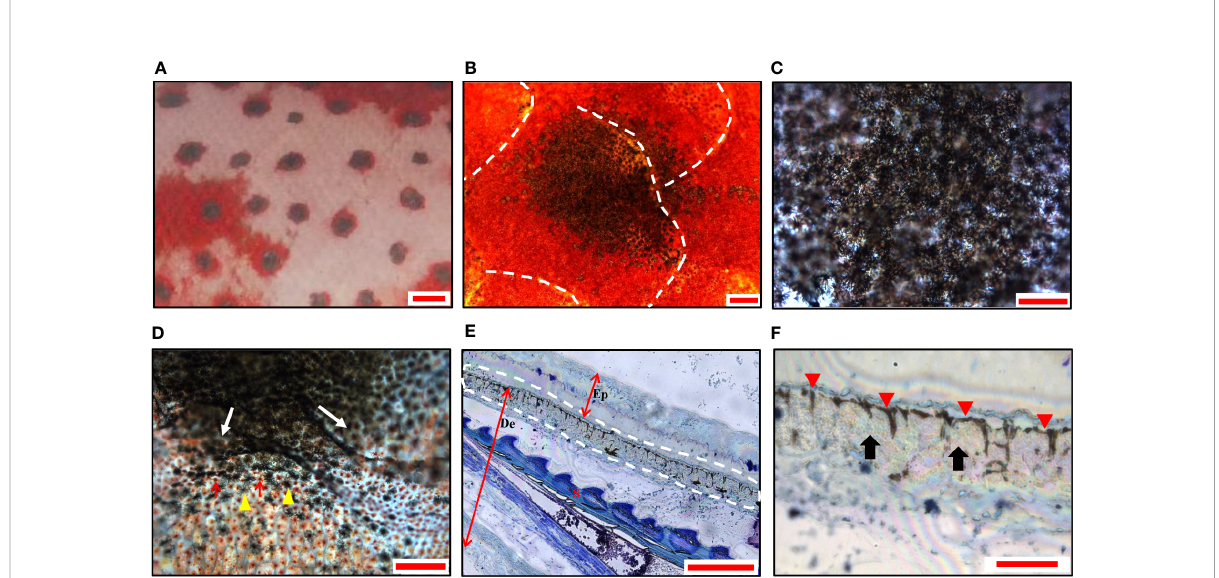
FIGURE 3 Morphology and chromatophores distribution of black spots in leopard coral trout. (A) A magni fi ed image of the skin shows black spots with irregular shaped. (B) A panoramic image shows black spots distributed over multiple scales under a light microscope. (C) The center of the spot is black. (D) The edges of the black spots (white arrows). Melanophores (yellow arrowheads); Erythrophores (red arrows). (E) A representative image of semi-thin sections (toluidine blue staining), shows continuously dispersed melanophores in the dermis. The white dashed line indicates the chromatophores. Ep, epidermis; De, dermis; S, scale. (F) The magni fi cation of the partial image in (E) shows dispersed melanophores (red arrowheads) and covered iridophores (black arrows). Scale bars: 2 mm (A) ; 200 m m (B) ; 100 m m (C – E) ; 25 m m (F) .